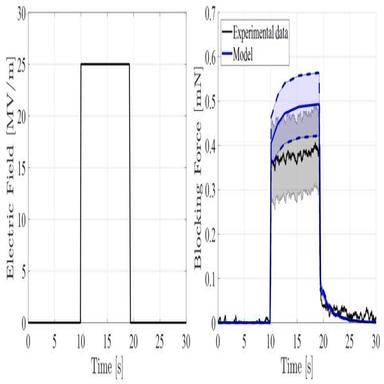
Time transient experimental and model blocking force when a square electric field input is applied to (at least) three soft actuators with transversally aligned nanofibers integrated in PDMS. The blue shaded areas represent the simulation results with the relative permittivity values spanned between 9 and 12, while the gray shaded areas represent the standard deviation on the electromechanical characterization.